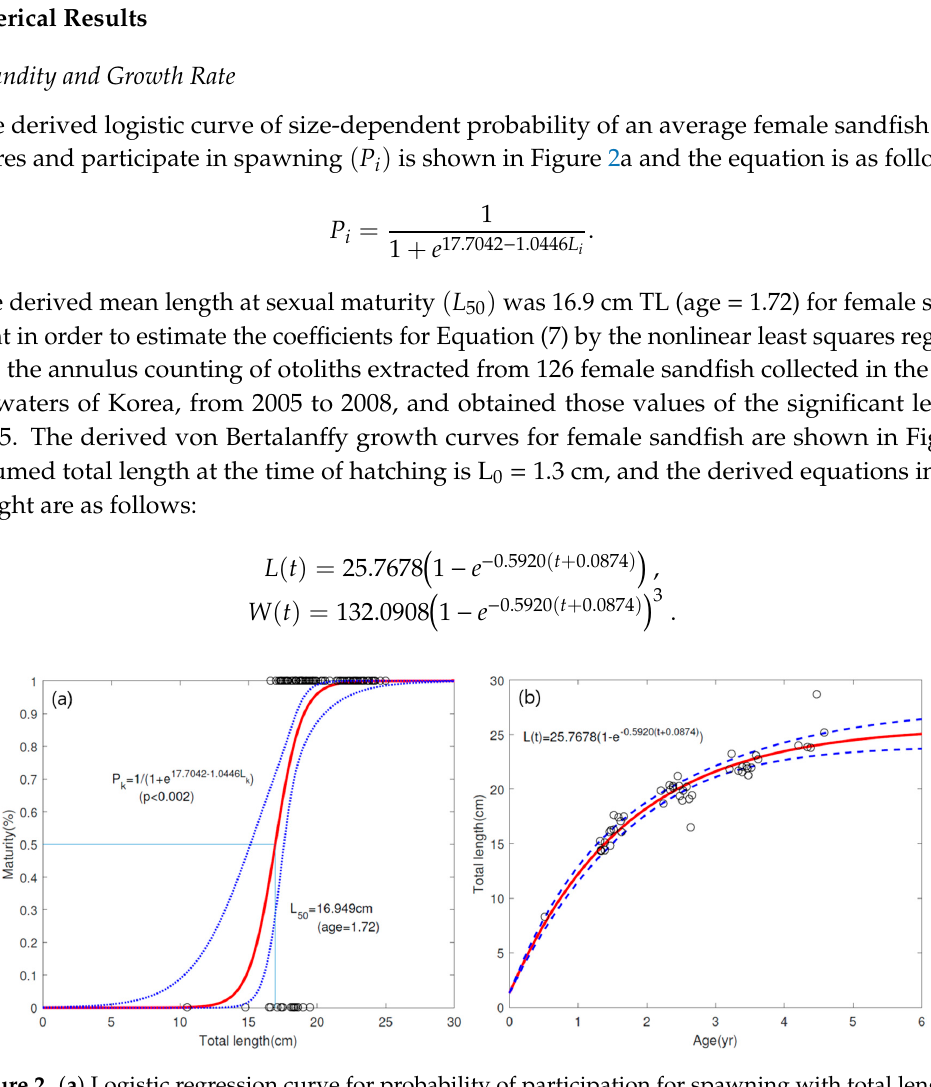
Figure 2. ( a ) Logistic regression curve for probability of participation for spawning with total length of 126 female sandfish ( Arctoscopus japonicas ) collected during spawning season (December 2005 and December 2006) in the eastern coastal waters of Korea; ( b ) Nonlinear regression curve of von Bertalanffy growth equation based on annulus counting of otoliths extracted from 46 female sandfish collected from 2005 to 2008, in the eastern coastal waters of Korea. The two dotted lines represent the 95% confidence interval for regression.